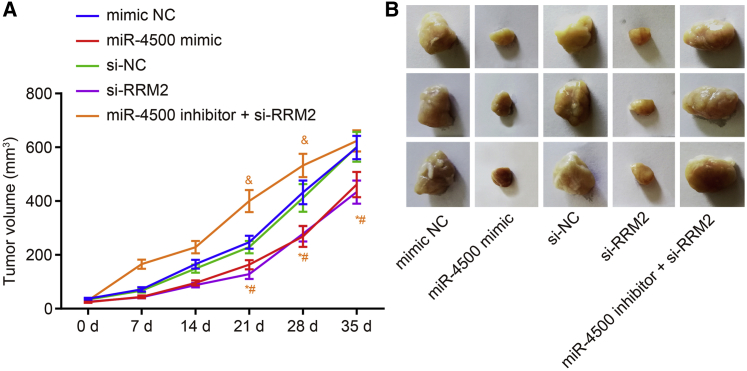
Overexpression of miR-4500 Downregulates RRM2 to Inhibit Breast Cancer Growth In Vivo(A) The growth of tumor volume in nude mice of each group after transfection and inoculation. (B) The tumor volume in vivo in each group detected by nude mice tumor xenograft assay. *, #, and &p < 0.05 versus the mimic NC group, si-NC group, and si-RRM2 group, respectively. The experiment was repeated three times independently, and data comparison at different time points in the figure was analyzed with repeated-measures ANOVA.